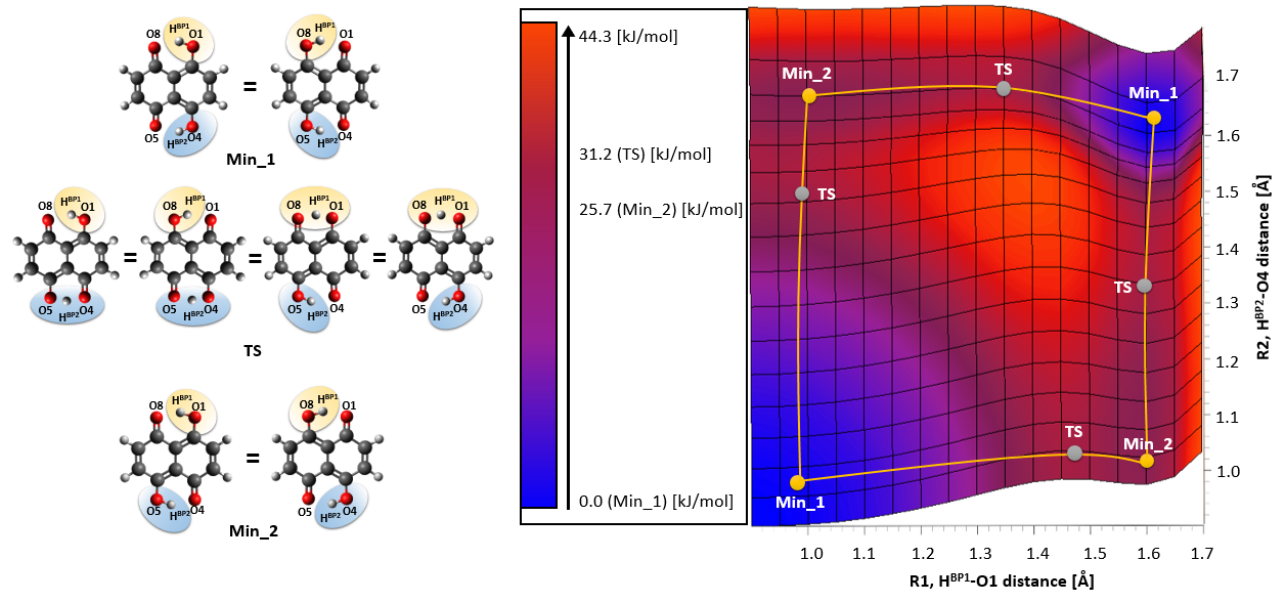
Figure 2. Two-dimensional potential energy surface (2D PES) for both proton motions between the donor and acceptor atoms (R1, H BP 1 -O1 and R2, H BP 2 -O4 bond distances) computed at CAM-B3LYP/6-311+G(2d,2p) level of theory (left). The corresponding isomeric structures indicated on the surface (right). Min_1—C 2 v energy minimum with the plane symmetry; Min_2—C 2 h energy minimum; TS—transition state.